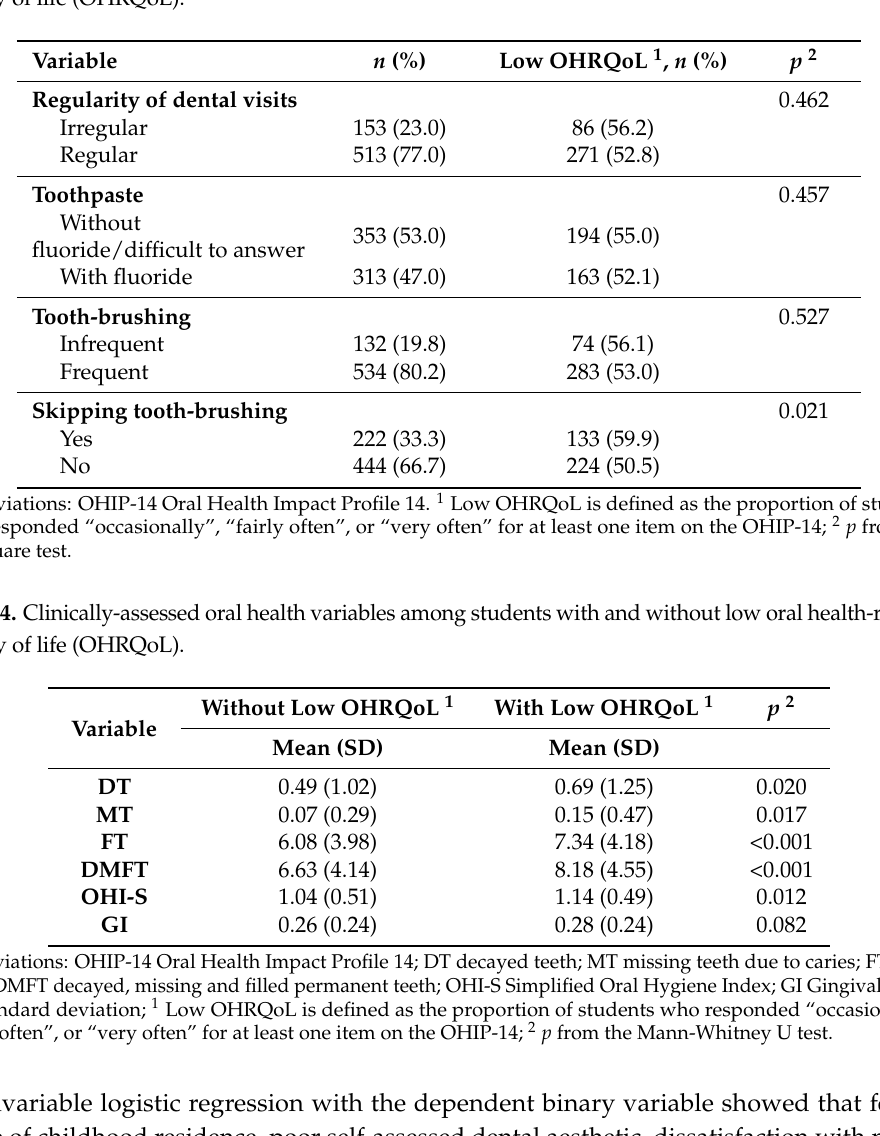
Table 3. Oral health behaviour of the study sample and proportion of students with low oral health-related quality of life (OHRQoL).